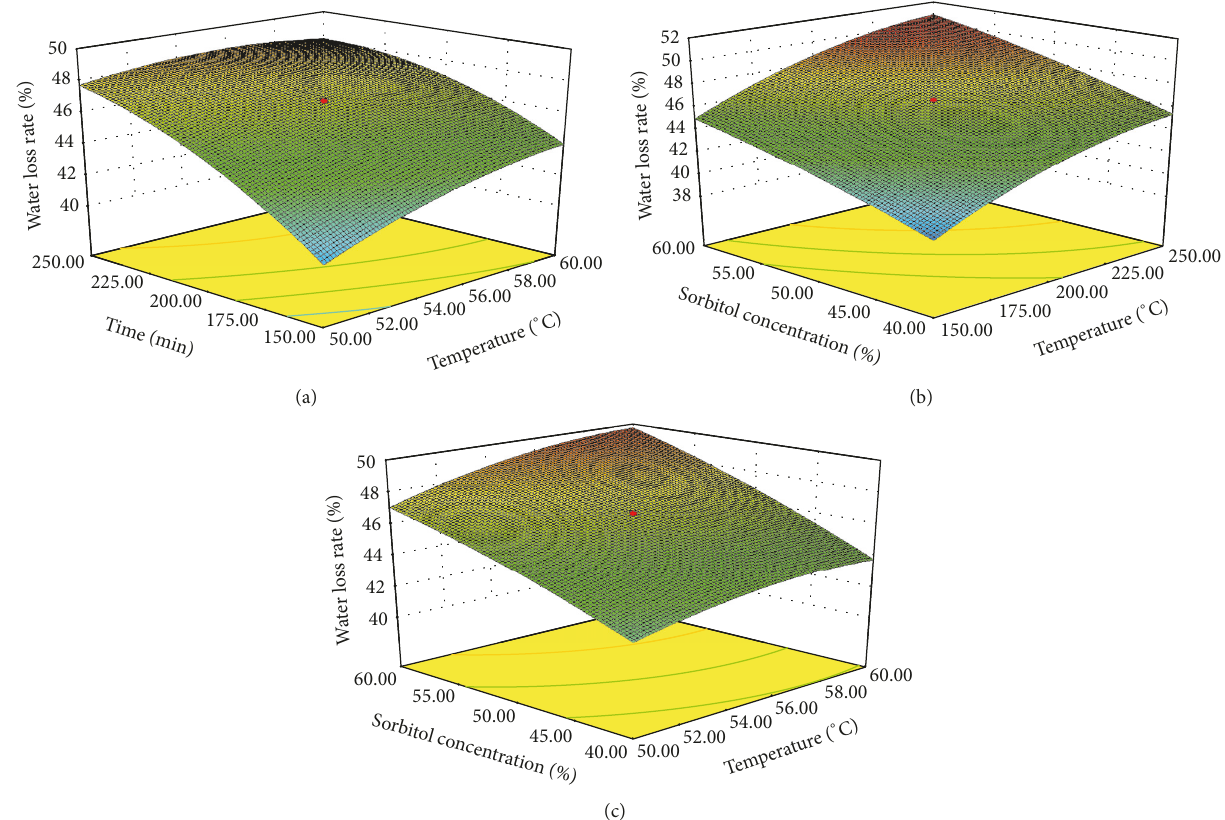
Figure 1: Response surface and contour plots for response of strawberry water loss rate during osmotic dehydration ((a) the interaction between the osmotic temperature and time; (b) the interaction between the osmotic time and sorbitol concentration; and (c) the interaction between the sorbitol concentration and osmotic